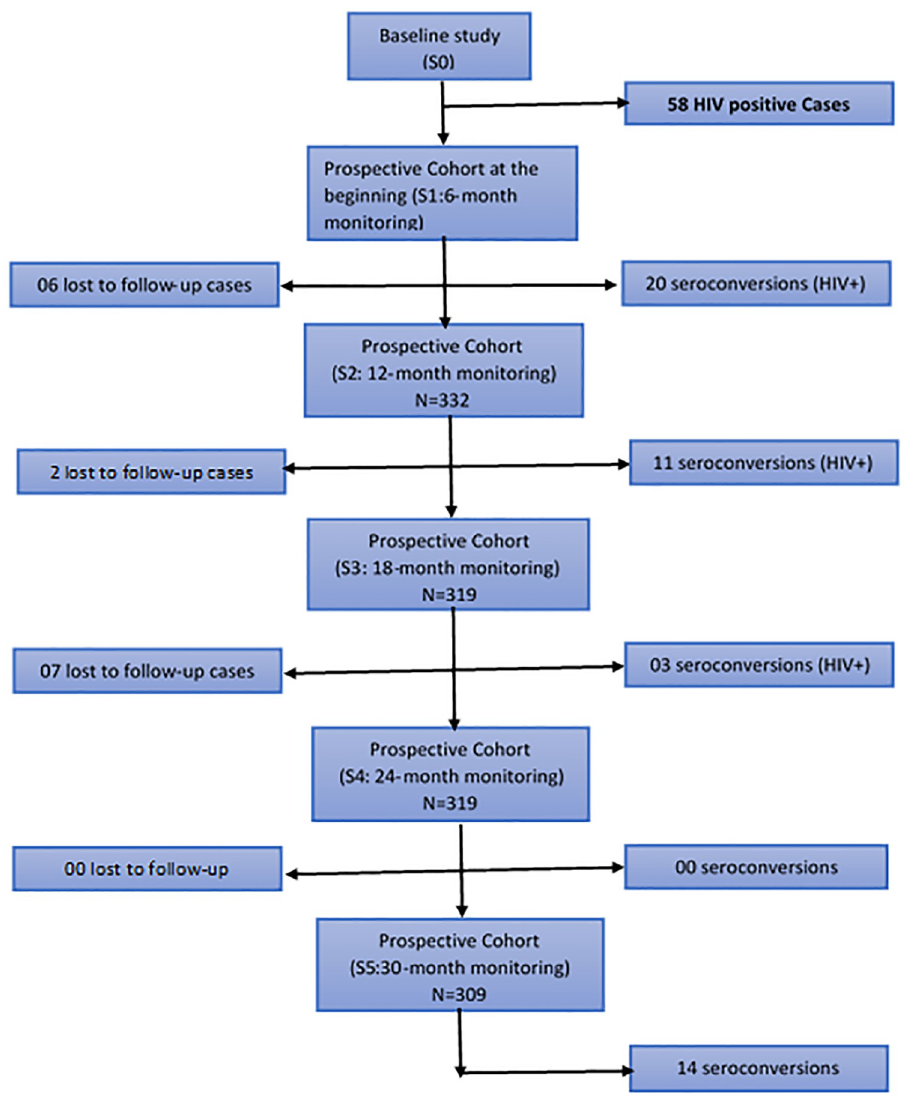
Fig 1. Follow-up chart of men who have sex with Men at the prospective cohort for 30 months for estimation of HIV infection, Benin 2018.